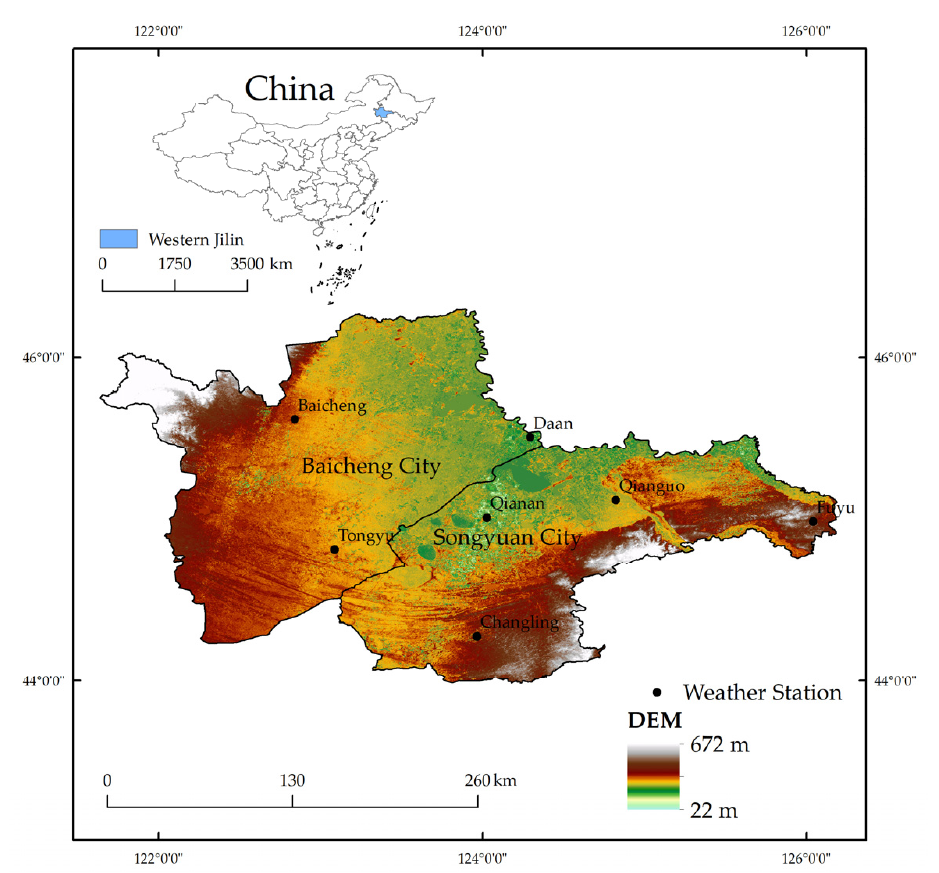
Figure 1. Location of the western Jilin.